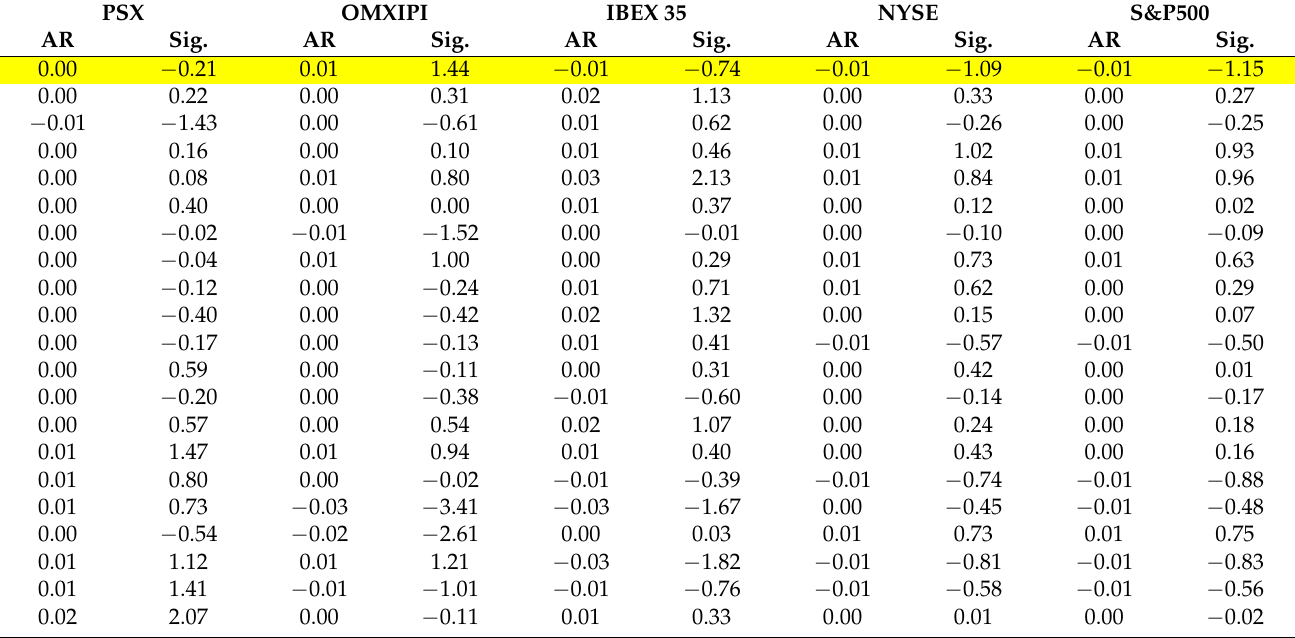
Table A22. Abnormal returns of the (0, +20) event window for Leak of Panama papers (Jurgen Mossack Resignation).